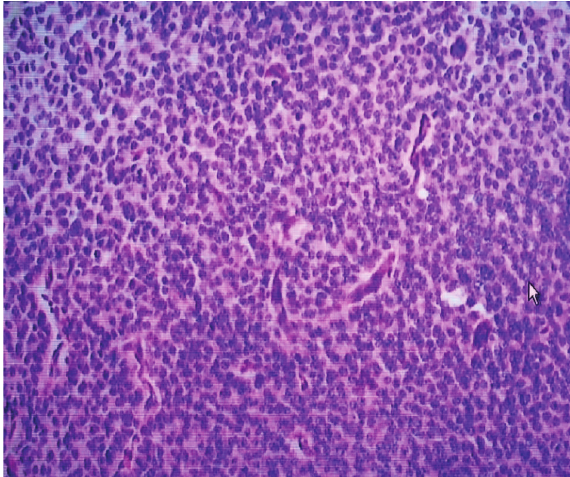
Figure 1: Histopathological slide of pinealoblastoma.